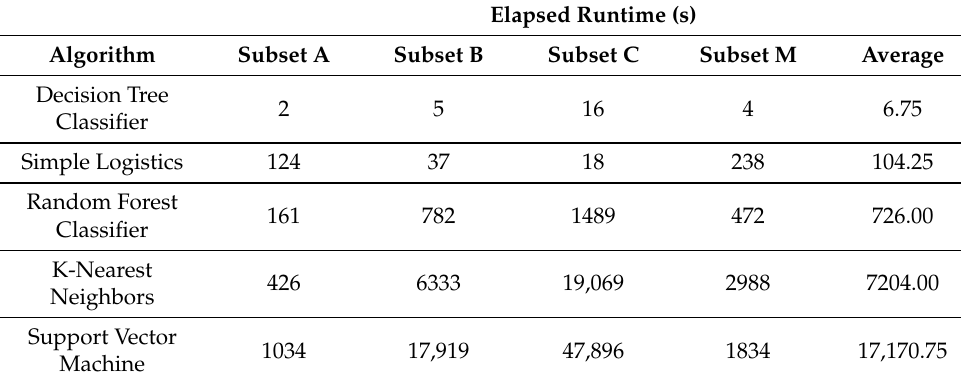
Table 4. Elapsed runtime results for each algorithm and per